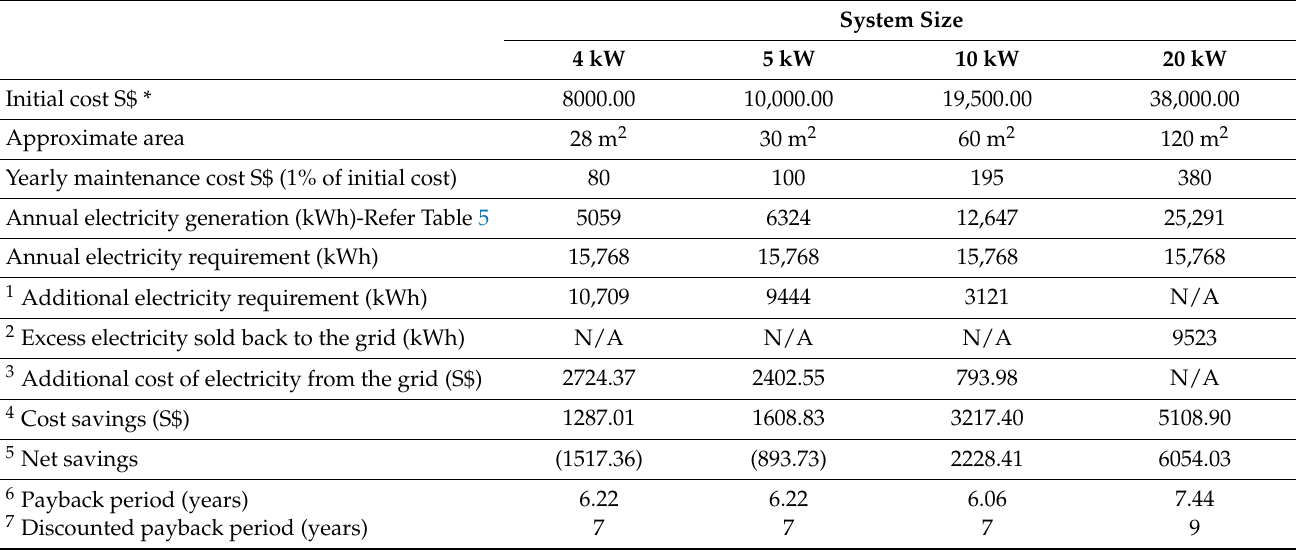
Table 6. Analysis on solar PV systems.